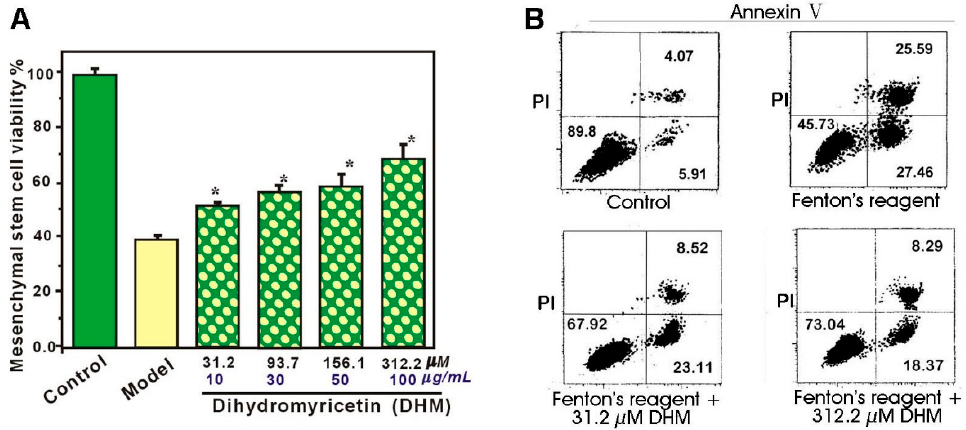
Figure 2. Dihydromyricetin (DHM) protects MSCs from Fenton’s reagent-induced damage (or apoptosis): ( A ) MTT assay. Fenton’s reagent refers to FeCl 2 plus H 2 O 2 . Experiments were performed with three batches of cells and each batch was tested in triplicate. Data are the mean ± SD. * p < 0.05, compared with MSC damage following Fenton’s reagent; ( B ) Flow cytometry analysis. Fenton’s reagent refers to FeCl 2 plus H 2 O 2 . MSCs were treated with or without Fenton’s reagent in the absence or presence